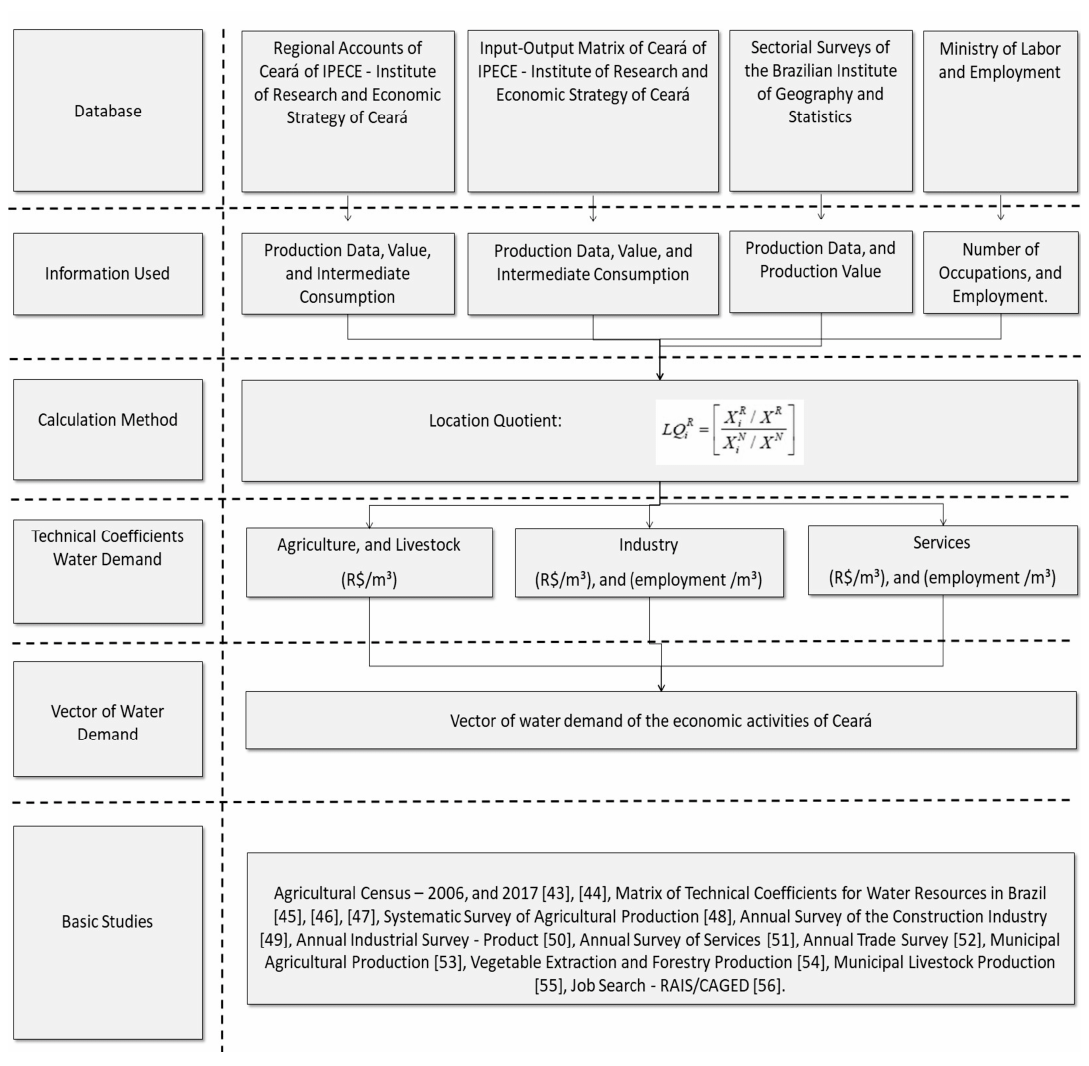
Figure 3. Methodology of the construction of technical coefficients and vector of water demand in the economic activities of Ceará [43–56].